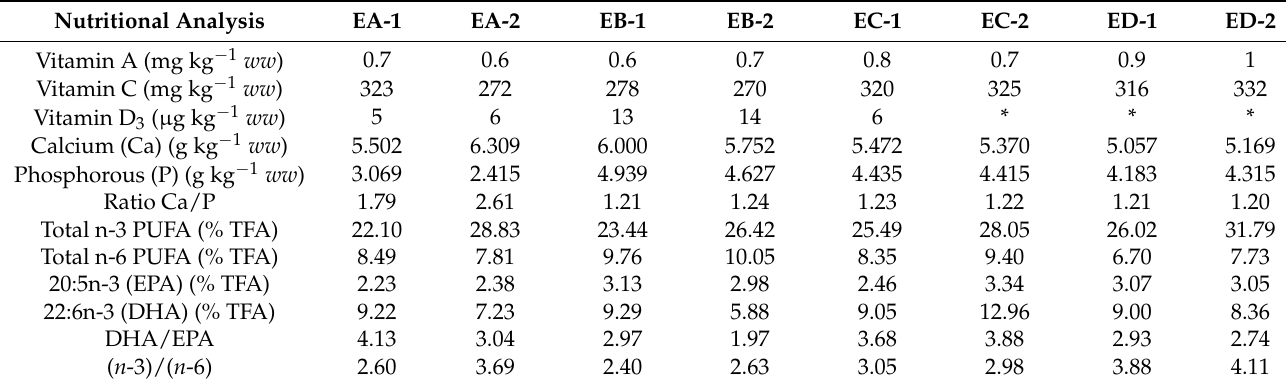
Table 5. Basic nutritional composition of Senegalese sole ( Solea senegalensis ) at 29 days after hatching for each tank (EA-1, EA-2, EB-1, EB-2, EC-1, EC-2, ED-1, ED-2). DHA: docosahexaenoic acid; EPA: eicosapentaenoic acid; PUFA: polyunsaturated